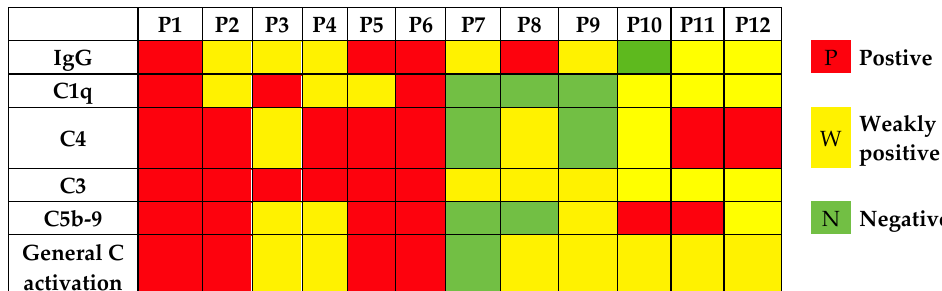
Figure 6. Detection of C3 and C5b-9 in liver sections by immunofluorescence analysis. The panel shows representative immunofluorescence images obtained from the analysis of several sections of liver autopsy samples from 12 SARS-CoV- 2-positive and 3 SARS-CoV-2-negative cases. See legend to Figure 1 for further details. White arrows indicate vessels in the portal area. Scale bar = 50 µm. Table 5. Complement deposition in livers. Table 5. Complement deposition in